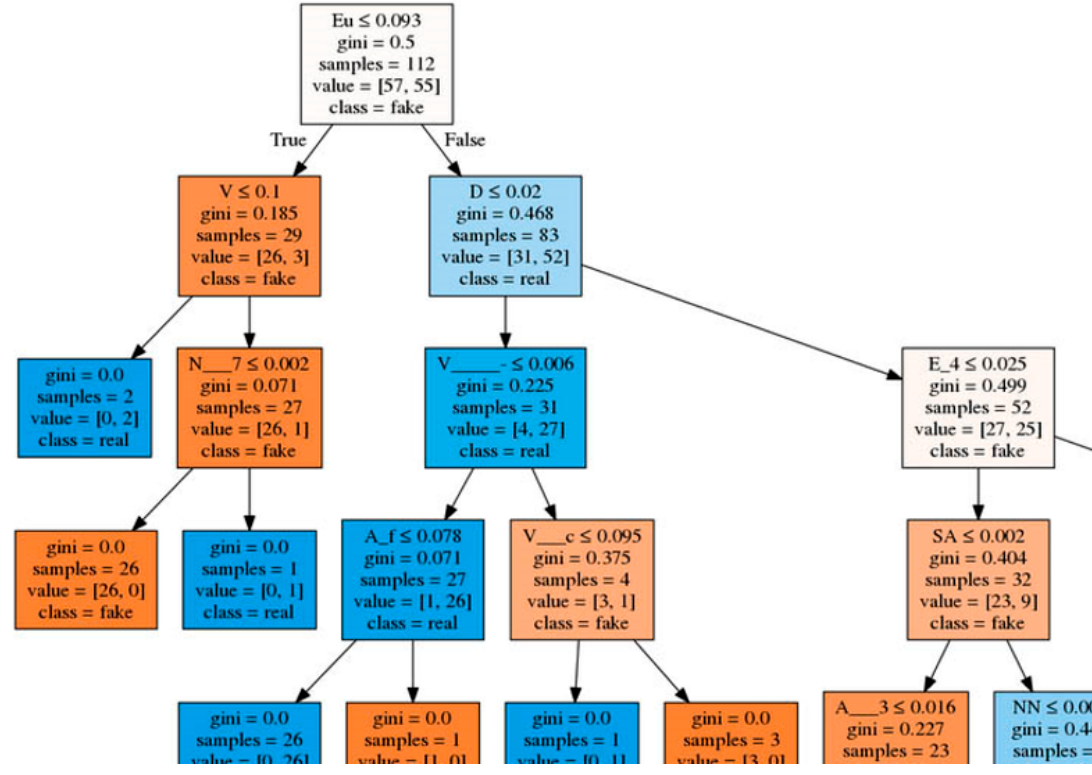
Figure 7. Sample part of the created decision tree.